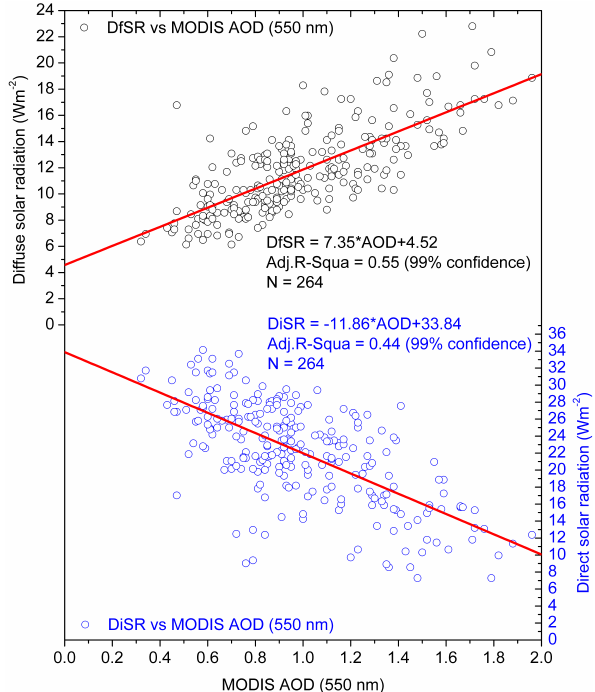
Fig. 4. Same as Fig. 3, but in summer.